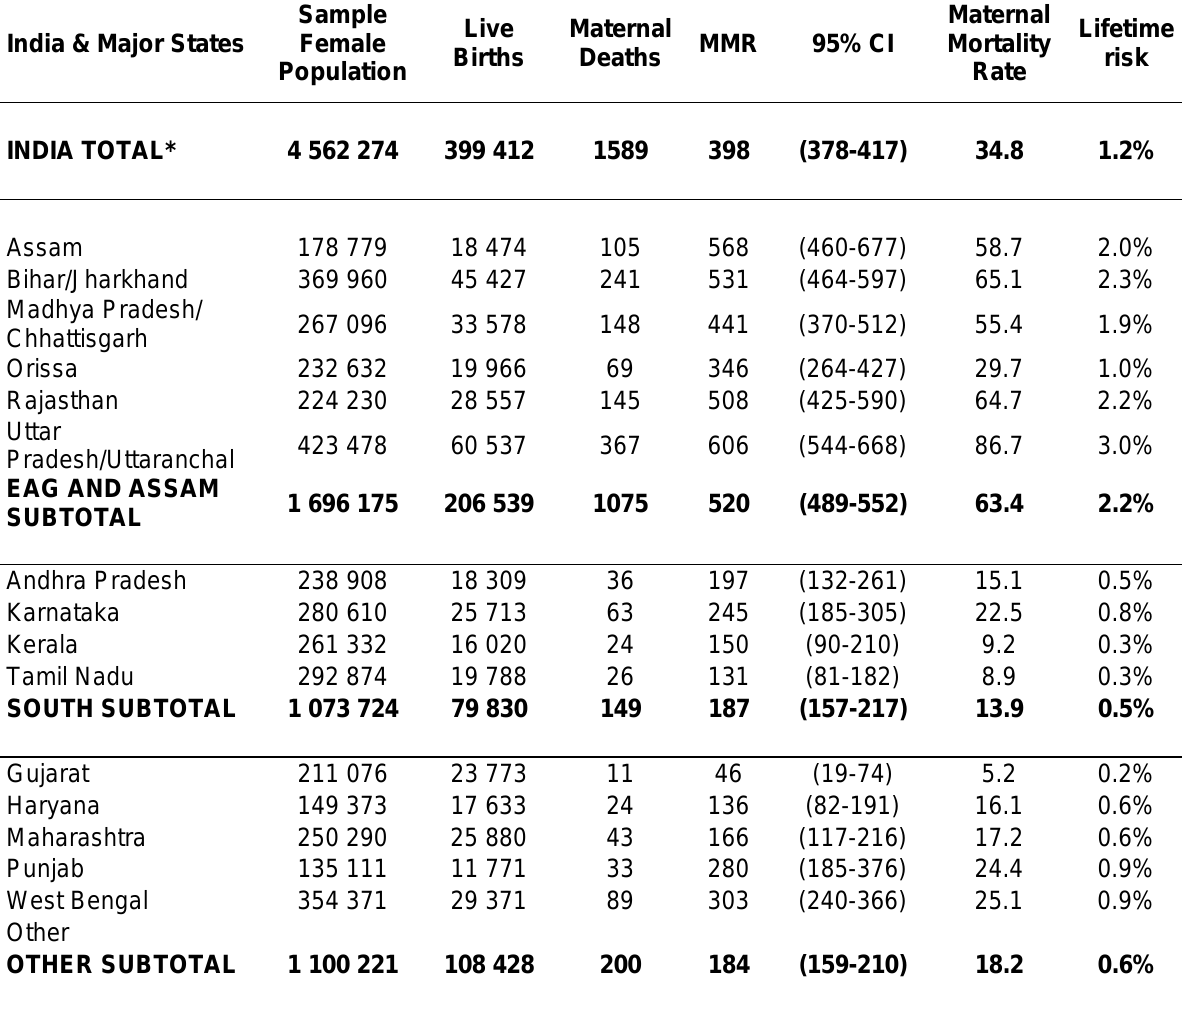
Table 1: Live Births, Maternal Deaths, Maternal Mortality Ratio in India by State from India & Major States